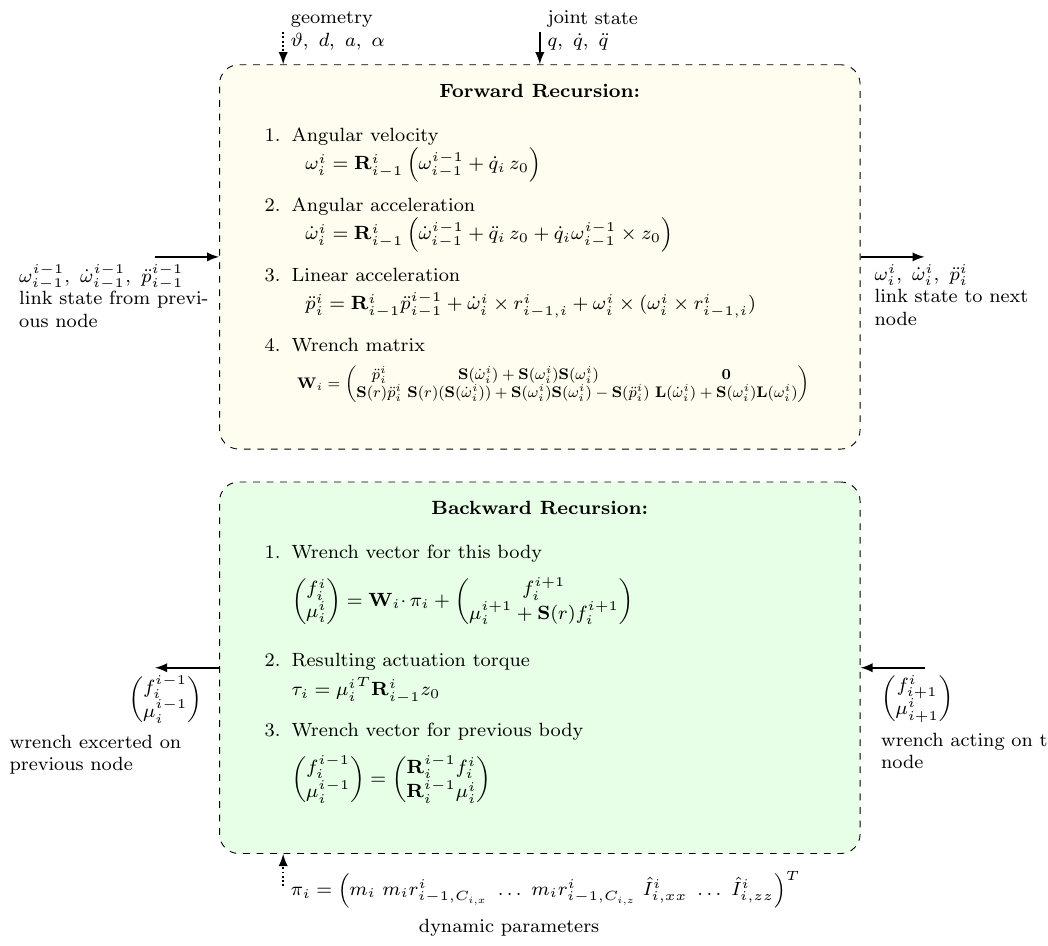
connections: local state (or reference) variables and configuration variables